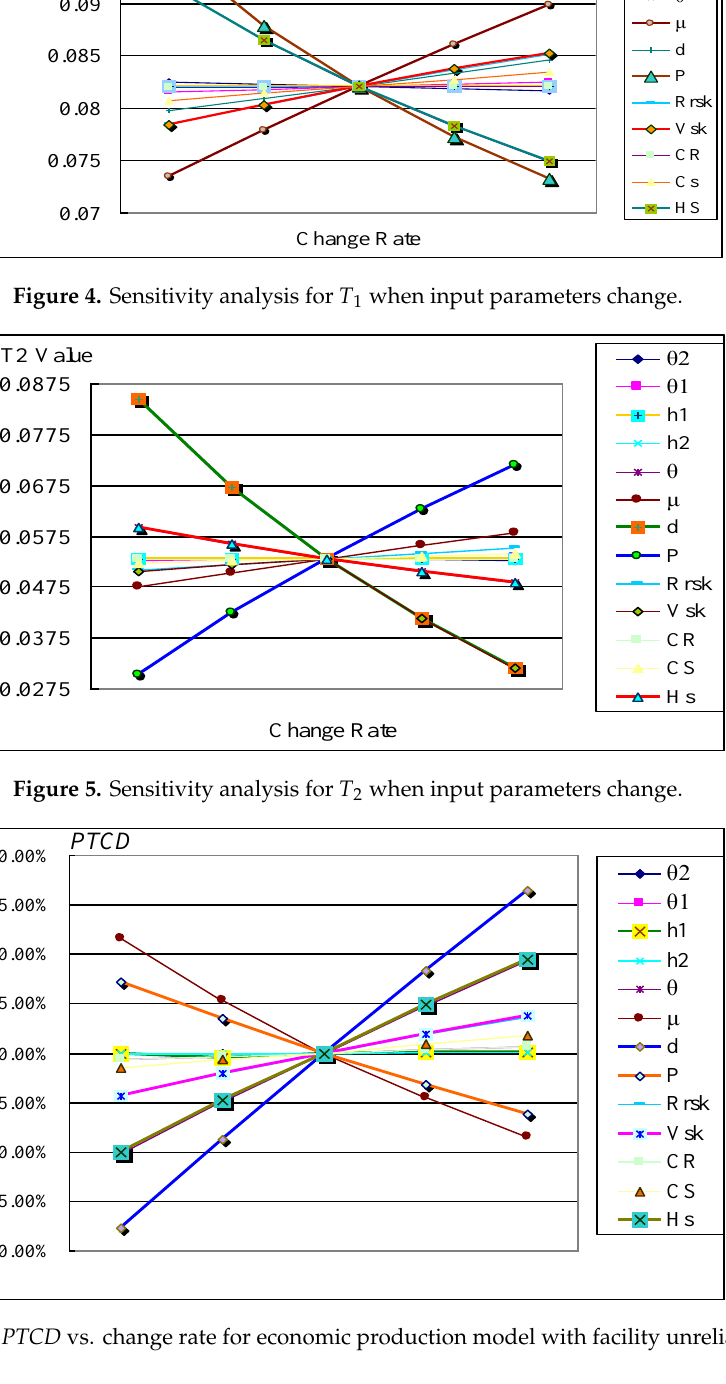
Figure 7. Sensitivity analysis for Q when input parameters change. 6. Conclusions The inventory models applying differential calculus are commonly used in existing research. A renewal reward approach is an alternate method for solving the inventory control of deteriorating items with a random breakdown or machine unavailability. This paper develops an EPQ model that considers facility unavailability and the imperfect items. The study assumed that a predetermined inspection scheduled. Shortages are allowed during facility unavailability due to preventive maintenance or unpredicted repair time. Imperfect quality rework, warranty, emergency purchase, and partial backorder are incorporated. Our study uses the renewal reward method and the fixed- point approach to solve the replenishment and inventory model. The approximate optimal solution is derived while using a fixed point iterative approach. The sensitivity analysis shows that the deteriorating rate, unit holding cost, and demand rate should be considered in designing the inspection plan and the replenishment policy when facility unavailability and imperfect items exist. Further research can be extended to consider the different partnership contract with supply chain members. Revenue sharing or price discount contract with supplier and trade credit can be incorporated. Furthermore, when considering the environmental aspect, such as from the production, maintenance, rework, and inventory, another interesting future work is to develop a green production system.